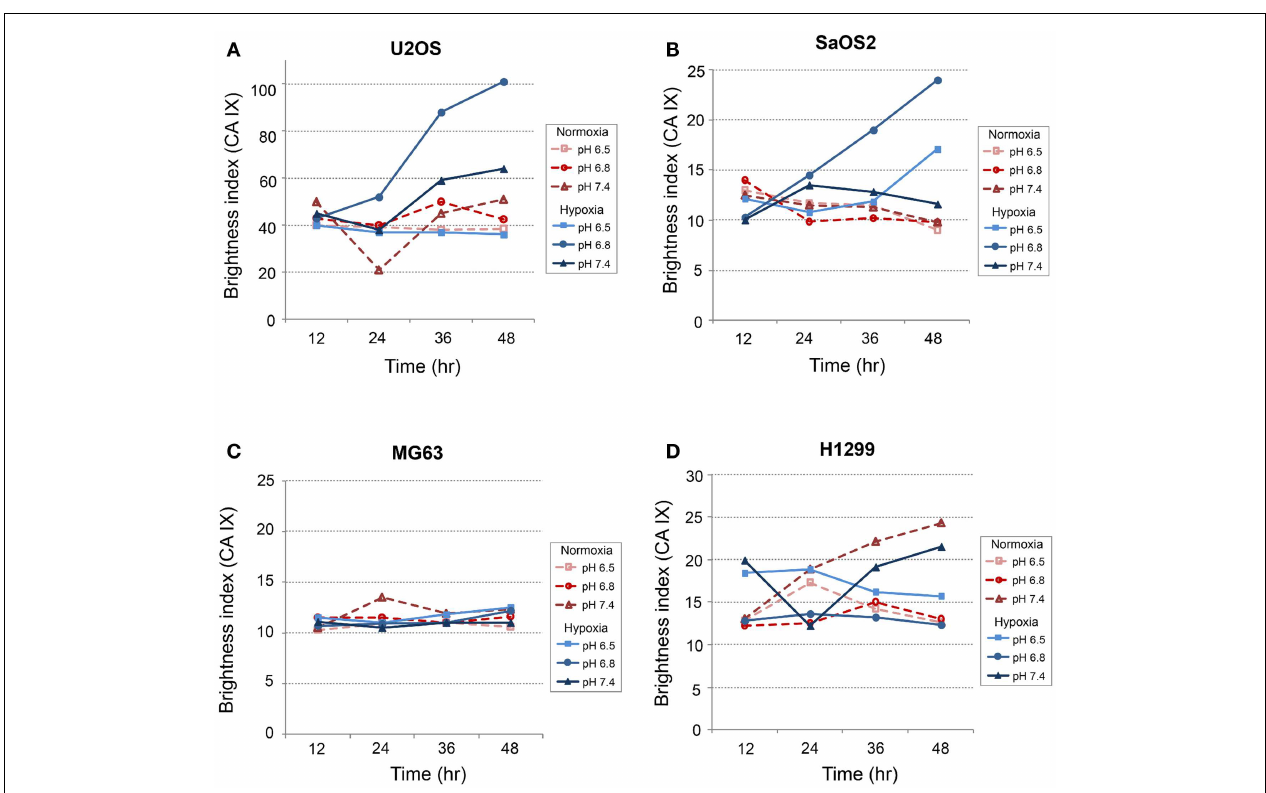
FIGURE 9 | Expression level of CA IX in (A) SaOS2, (B) U2OS, (C) MG63, and (D) H1299 cells